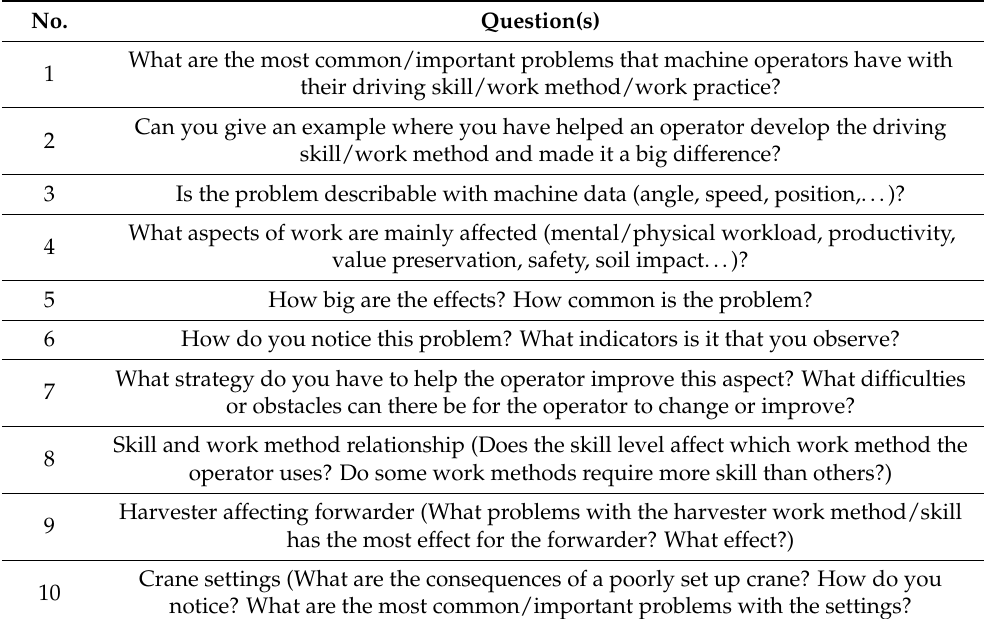
Table A1. Interview guideline with ten main